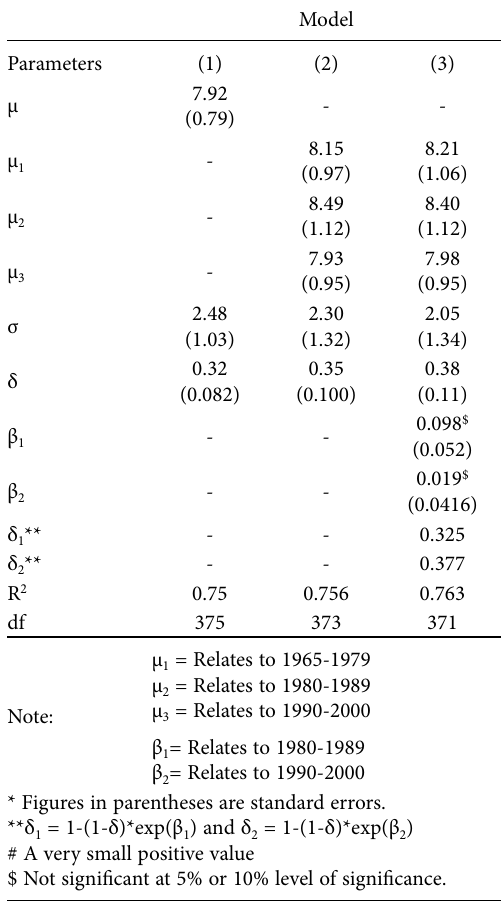
Table 6. Regression Results of Renewal Models for PVP Certificates-Ornamental